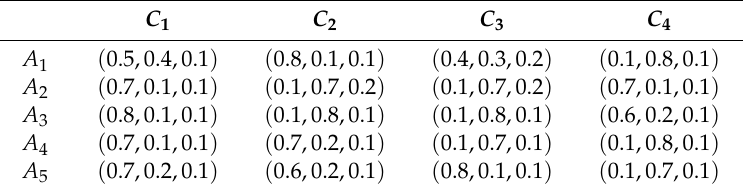
Table 1. Decision matrix A 1 from expert E 1 .